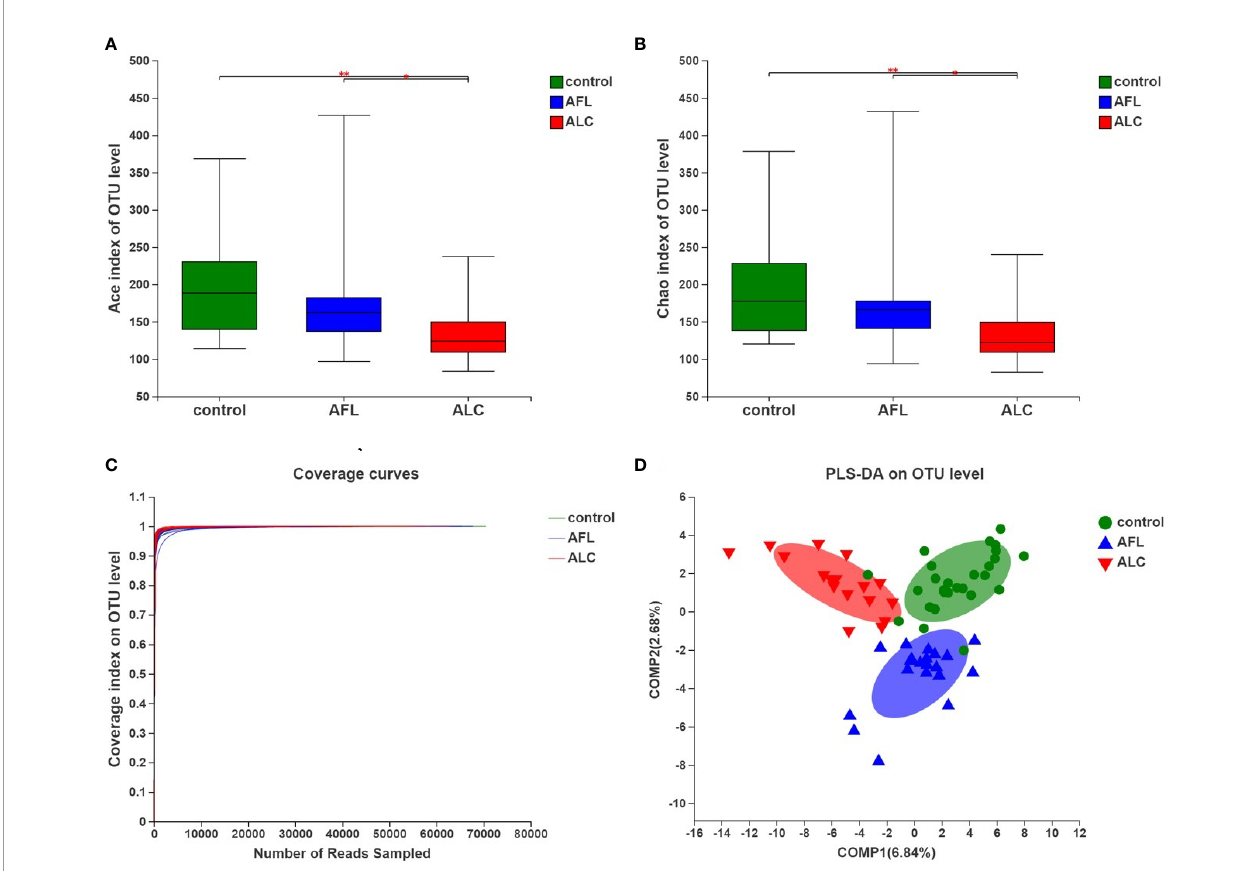
FIGURE 1 | The community diversity of gut microbiota in patients with alcoholic fatty liver (AFL) or alcoholic liver cirrhosis (ALC) compared with healthy controls (control). (A) The Ace diversity indexes, (B) The Chao diversity indexes, (C) Coverage curves on OTU level, and (D) PLS-DA on OTU level. *P < 0.05, **P < 0.01.